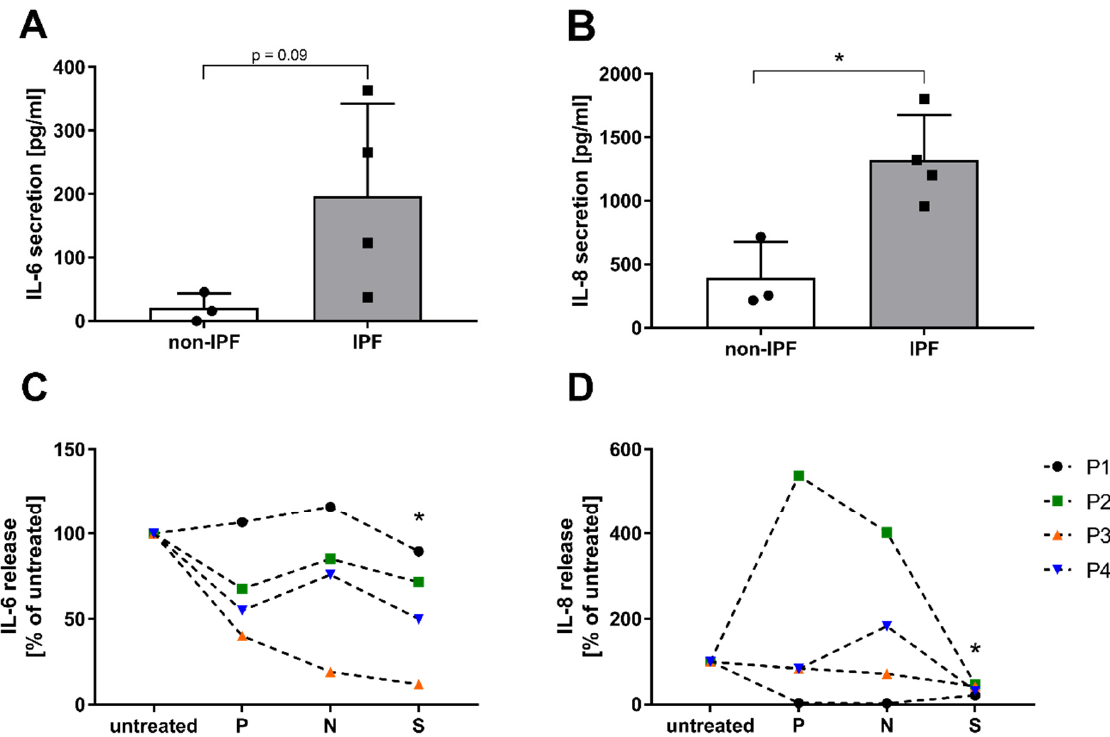
Figure 6. The effect of drug treatment on inflammatory cytokine secretion by HBE cells from patients with IPF ( A ) IL-6 and ( B ) IL-8 secretion in HBE cells from IPF patients ( n = 4) and controls ( n = 3), presented as mean ± SD. (* p < 0.05). ( C ) IL-6 and ( D ) IL-8 secretion in HBE cells from IPF patients after stimulation with pirfenidone (1 mM), nintedanib (0.1 µ M) or saracatinib (1 µ M) for 24 h ( n = 4). Data are presented as a percentage of the untreated cells calculated for each patient ( C , D ) (* p < 0.05).